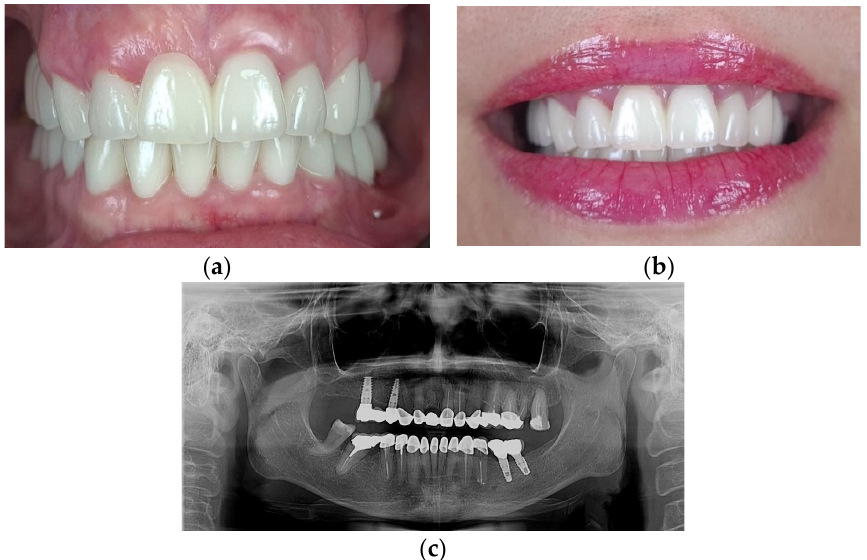
Figure 12. The final result of the full-mouth rehabilitation: ( a ) Intraoral aspect of the restorations; ( b ) The improved smile with minimal gingival display; ( c ) Panoramic X-ray after one year.